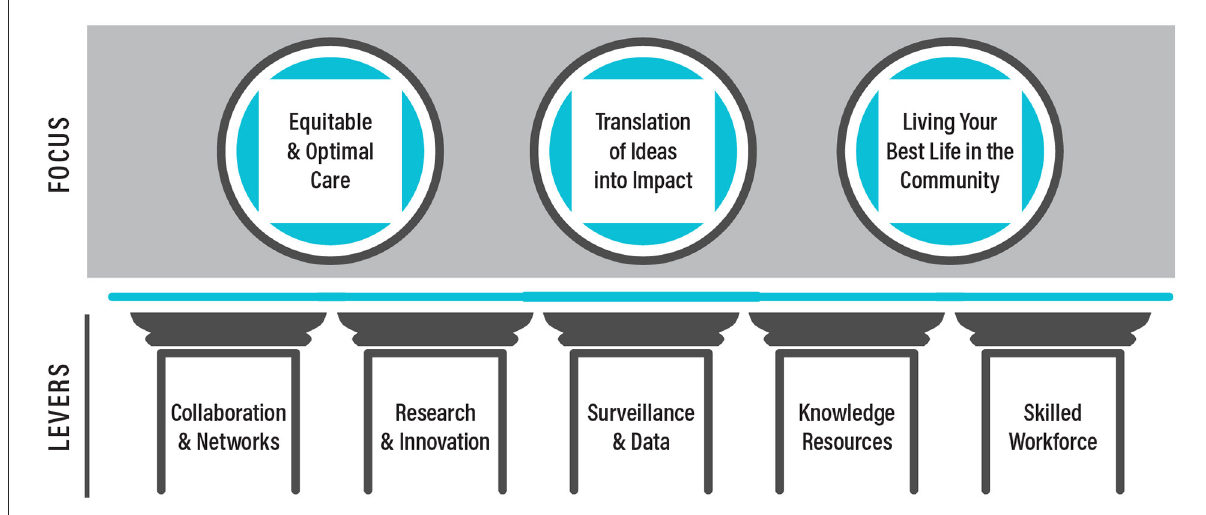
FIGURE1 The three areas of focus and five pillars in the SCI Care in Canada: A Framework for Strategy and Action .